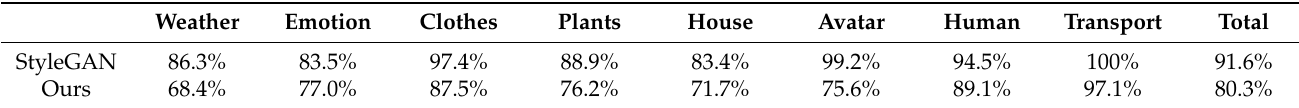
Table 3. The visual Turing test accuracy of 8 types of icons.